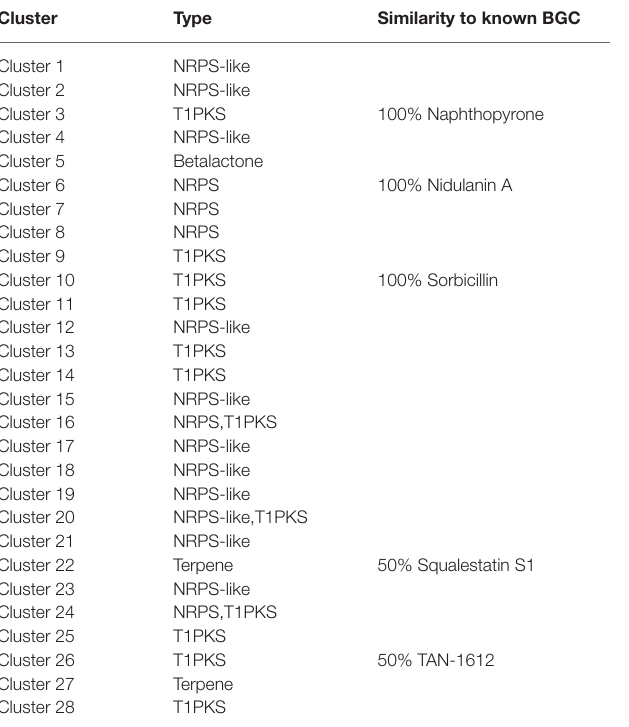
TABLE 2 | Secondary metabolite gene cluster in P2648.